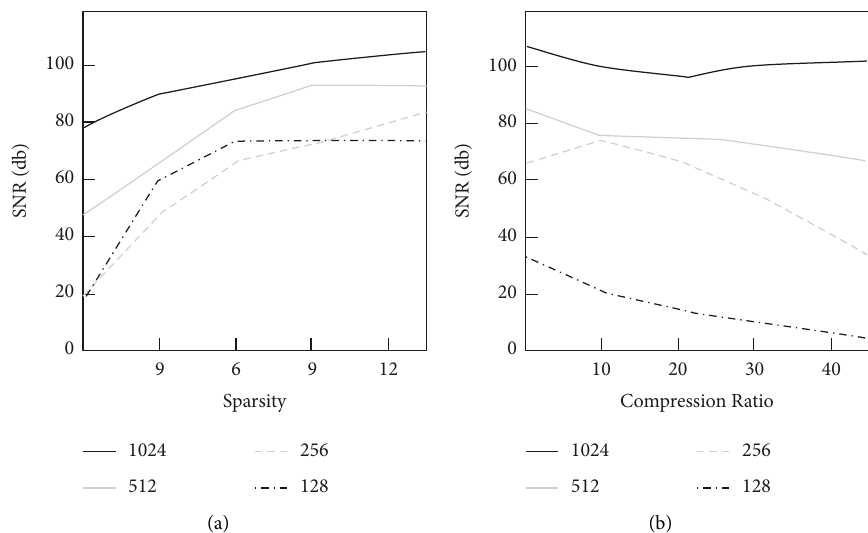
Figure 5: Dictionary SNR comparison of different sizes. (a) Signal-to-noise ratio at different sparsity. (b) Signal-to-noise ratio at different compression ratio.